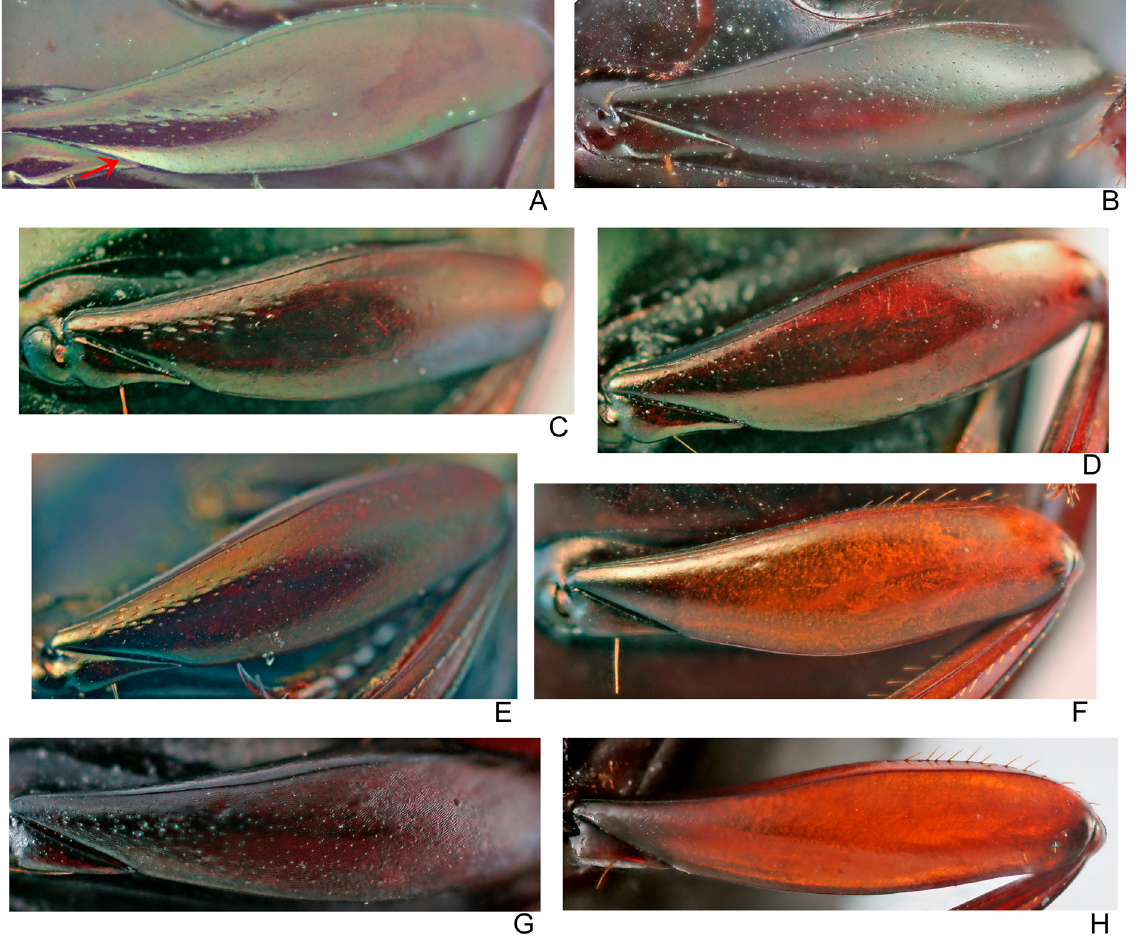
Fig. 13. Morphological variation in the metafemora of Sylvicanthon Halffter & Martínez, 1977. A . S. foveiventris (Schmidt, 1920) . Note the presence of coarse elongate punctures at the base of the metafemur (arrow) and the tegument without microsculpture. B . S. obscurus (Schmidt, 1920). Observe the tegument entirely covered by coarse non-elongate punctures. C . S. monnei sp. nov. D . S. mayri sp. nov. E . S. furvus (Schmidt, 1920). F . S. edmondsi sp. nov. G . S. bridarollii (Martínez, 1949) (southern populations). H . S. bridarollii (Martínez, 1949) (northern populations). Note the differences in colouration and in the presence of coarse punctation at the base of metafemur in the two ends of the clinal variation observed in S. bridarollii